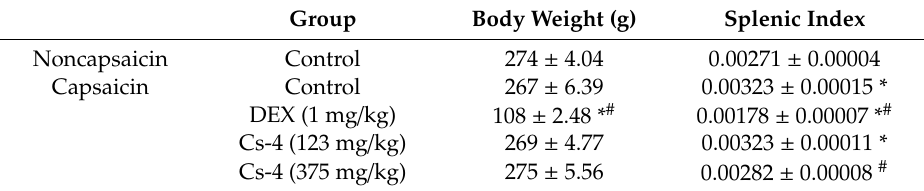
Table 1. The effects of Cs-4 on the body weights and splenic index of capsaicin-challenged rats.